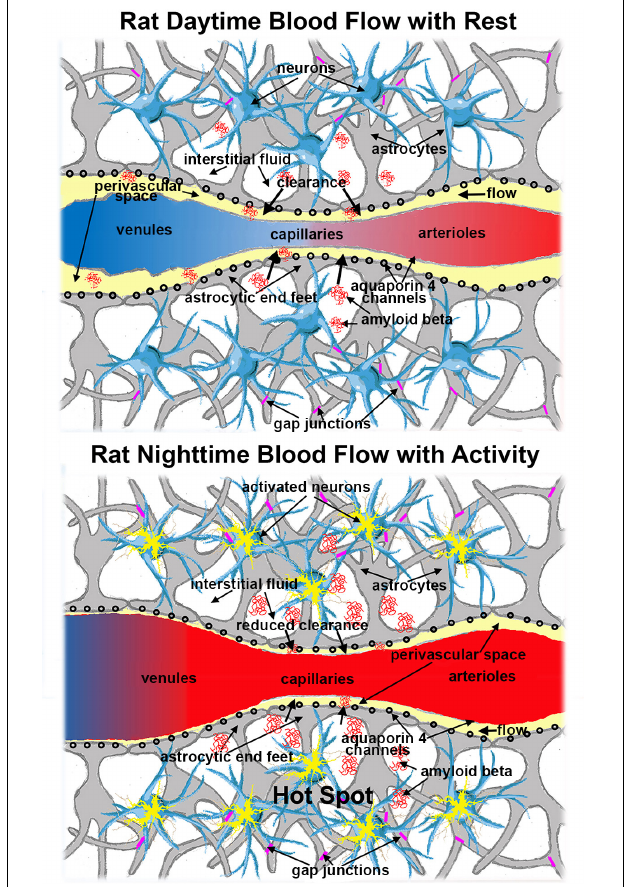
FIGURE 4 | Schematic showing the expanded PVS (yellow) in the microcirculation during the daytime (inactive phase) as compared to the reduced PVS during the night (active phase). Red denotes oxygenated hemoglobin and blue deoxygenated hemoglobin. The increased cerebral blood volume (CBV) in areas of brain activity is the mechanistic foundation of BOLD imaging and functional imaging with